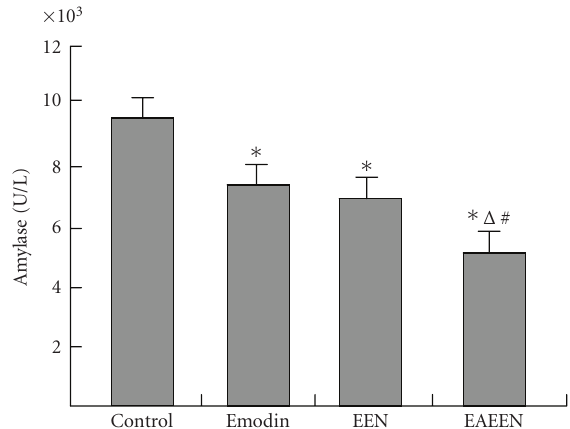
Figure 1: Changes of serum amylase levels in di ff erent groups. ∗ P < . 05 versus control group; Δ P < . 05, EAEEN group versus Emodin group; # P < . 05, EAEEN group versus EEN group. EEN: early enteral nutrition. EAEEN: emodin-assisted early enteral nu- trition.